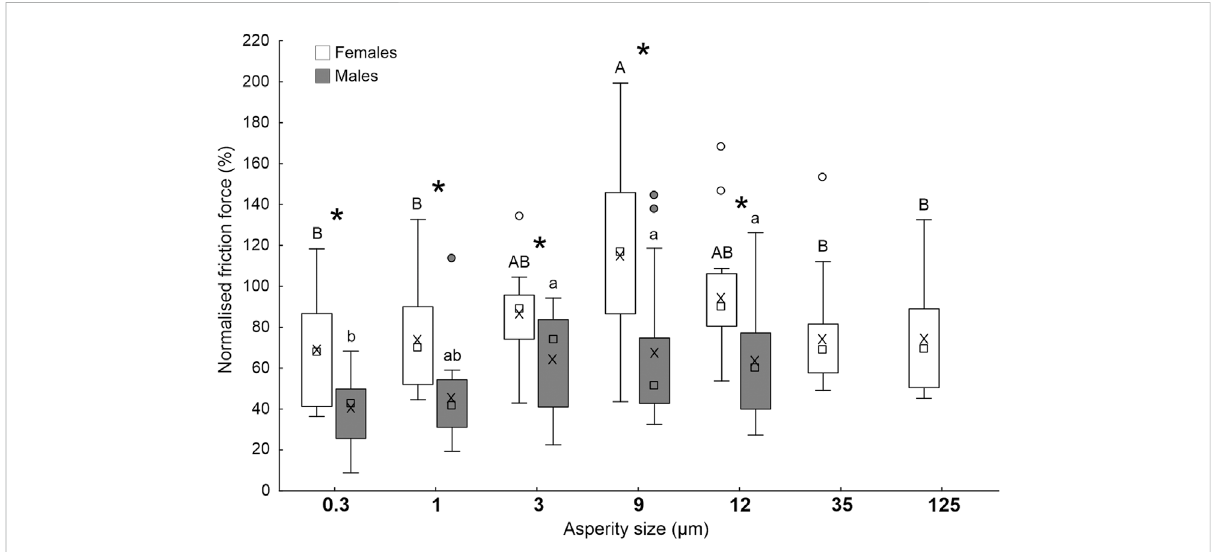
FIGURE 8 Frictionforceof A.bifasciatus femalesandmalesonpolishingpaperwithdifferentasperitysizes(0.3,1,3,9,12,35and125 μ m;35and125tested only in females), normalised to the insect friction force recorded on hydrophilic glass as reference. Boxplots show the interquartile range and the medians, whiskers indicate the 1.5 × interquartile range and “ ° ” shows outliers. Boxplots with different upper case letters and lower case letters, respectively, are signi fi cantly different at p < 0.05 (Tukey unequal N HSD post hoc test, One-way ANOVA). In the comparison between females and males, the asterisk (*) means signi fi cant difference at p < 0.05 ( t -test for independent